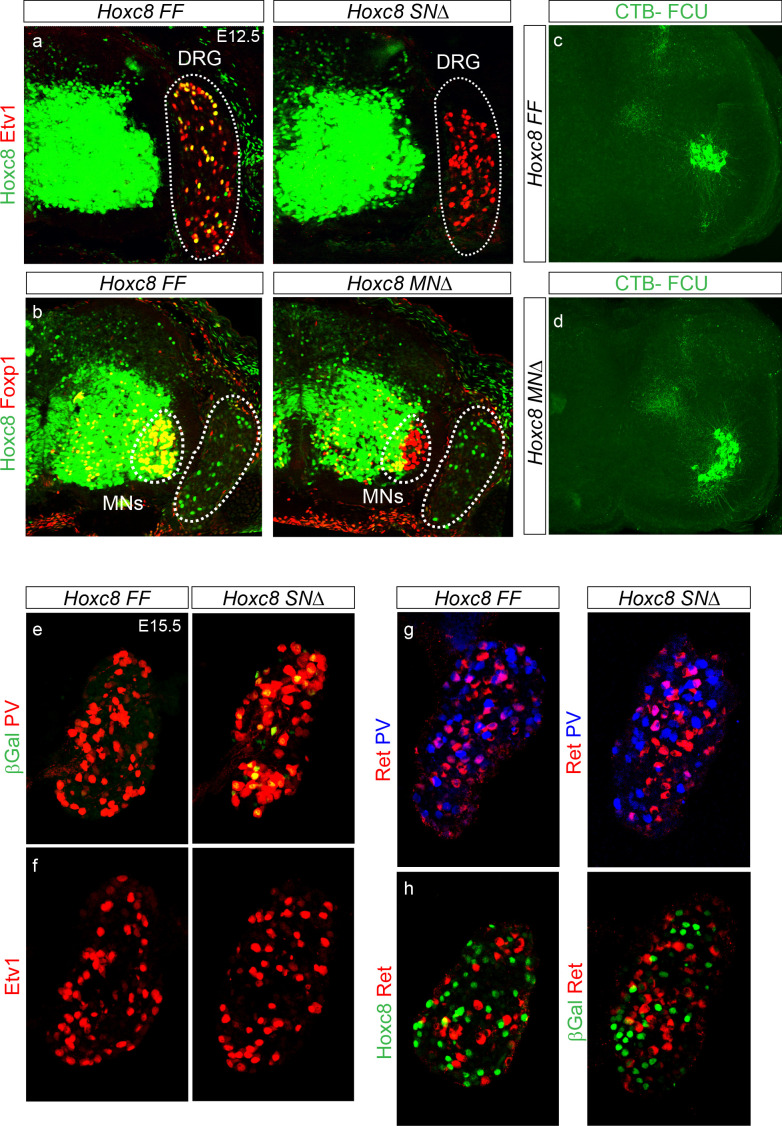
Preservation of sensory neuron identities in Hoxc8SN∆ mice.(a and b) Genetic approaches to study sensory-motor circuit development in the absence of Hoxc8. Cross sections of spinal cord with adjacent DRG in the caudal cervical region of E12.5 mice. In Hoxc8SN∆ mice, Hoxc8 is selectively removed from SNs in the DRG but expression is retained in MNs (a). Deletion of Hoxc8 in MNs of Olig2::Cre; Hoxc8LacZ-flox/ LacZ-flox mice (Hoxc8MN∆) with Hoxc8 expression in SNs comparable to that of control mice (b). (c–d) Altered location of FCU MNs in Hoxc8MN∆ mice. Images are maximum intensity projections of confocal Z-stacks encompassing the entire domain of the FCU motor pool. In Hoxc8MN∆ mice, FCU MNs shift ventrally. (e–h) Cross sections of caudal cervical DRG C8 in Hoxc8SN∆ and control mice at E15.5. (e) Comparable number of PV+ cells between Hoxc8SN∆ and control mice. βGal+ SNs survive and maintain PV expression after removal of Hoxc8. (f) No depletion of Etv1+ cells in SNs of Hoxc8SN∆ mice compared to that of control mice. (g) Similar profile of Ret+PV-, Ret+PV+, and Ret-PV+ neurons in Hoxc8SN∆ and control mice. (h) βGal+ SNs do not express Ret in the absence of Hoxc8.